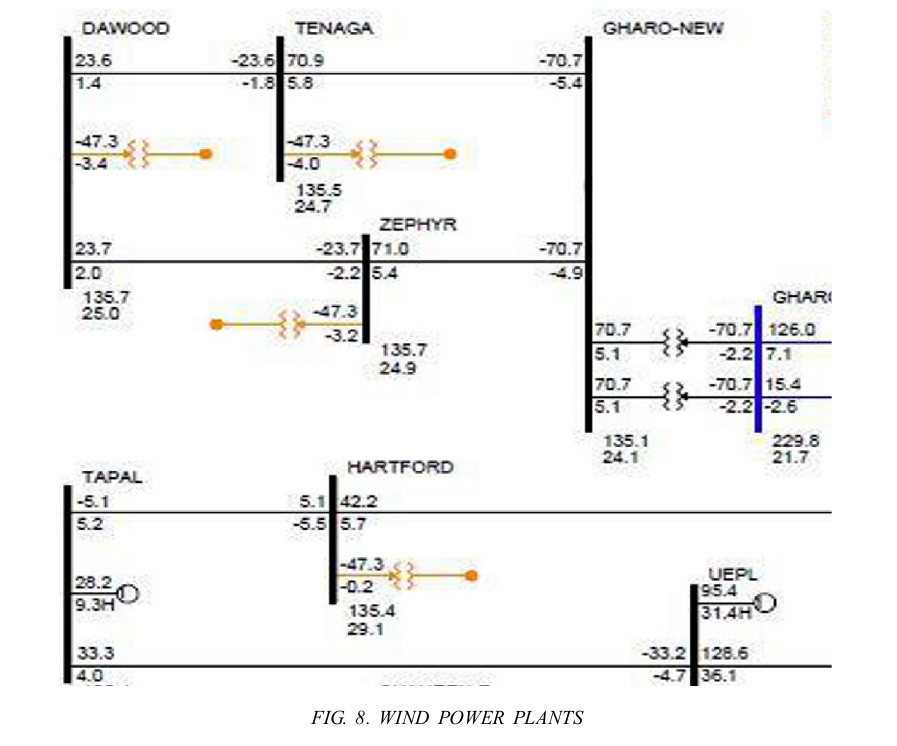
FIG. 8. WIND POWER